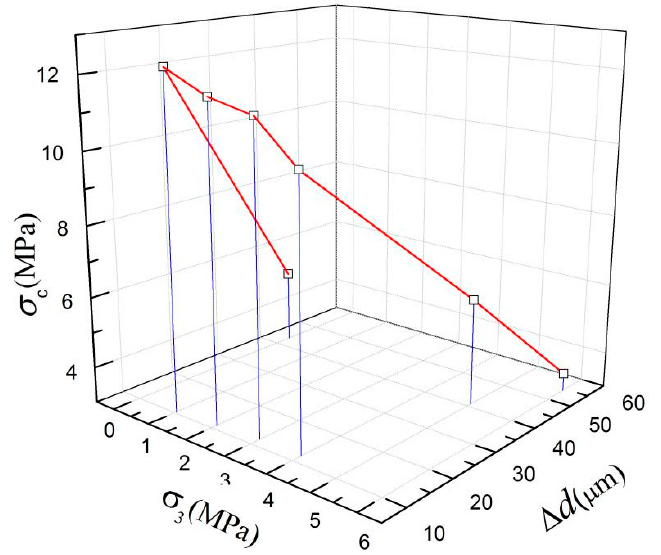
Figure 8. The relationship of uniaxial compressive strength, fissure width, and confining pressure of the coal sample under varied confining pressures after three cycles of liquid nitrogen injection.